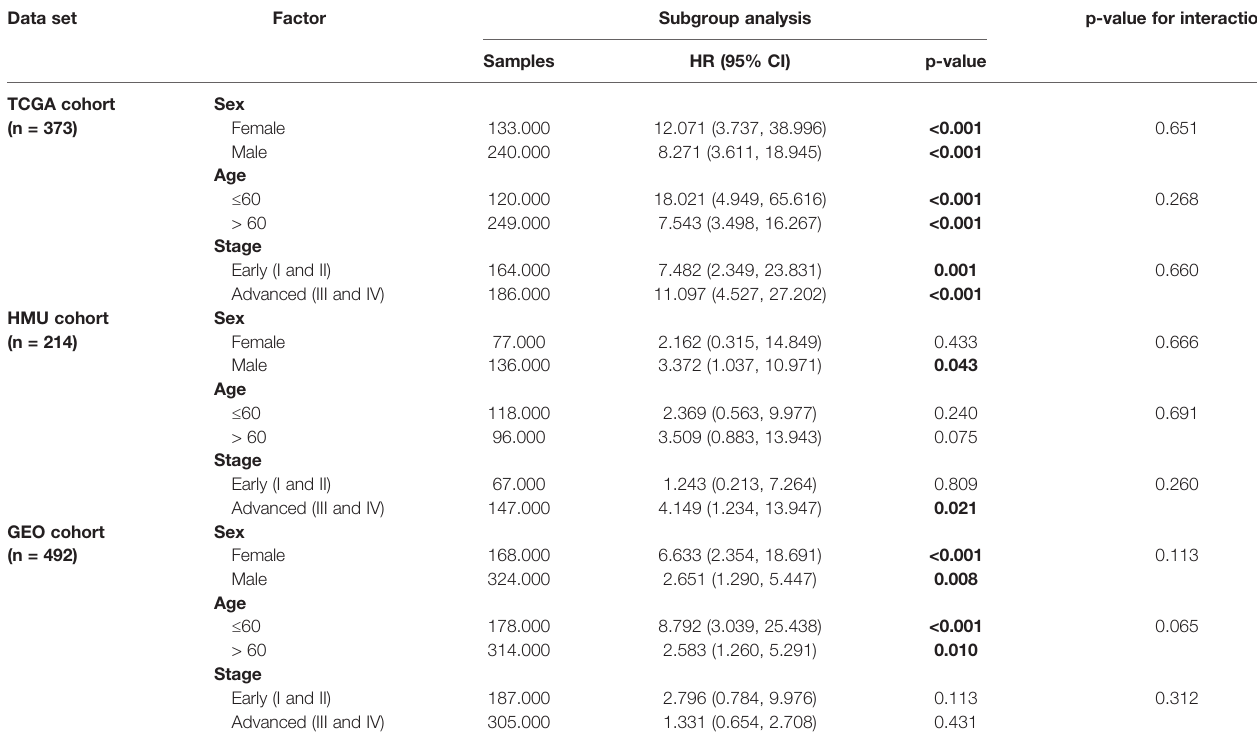
TABLE 3 | Subgroup analysis of the RNA processing-related signature.